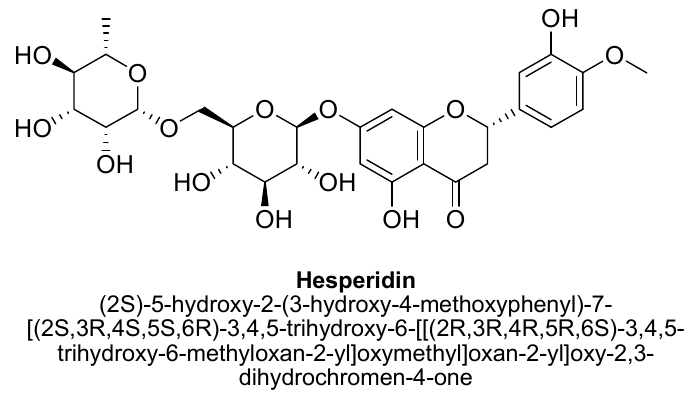
Figure 31. Hesperidin. Isosakuranetin-5-O-rutinoside is a new flavonoid and also known as 5-O-(6-rhamno- sylglucoside)-7-hydroxy-4 ′ -methoxyflavanone (Figure 32). This flavanone was isolated from hydroethanolic extract of leaves of plant Salvia elegans Vahl and found to possess antidepressant activity in animal model, i.e. , forced swimming test [123]. Further, reports on underlying anti-depressant mechanism of this new flavanone are not available.